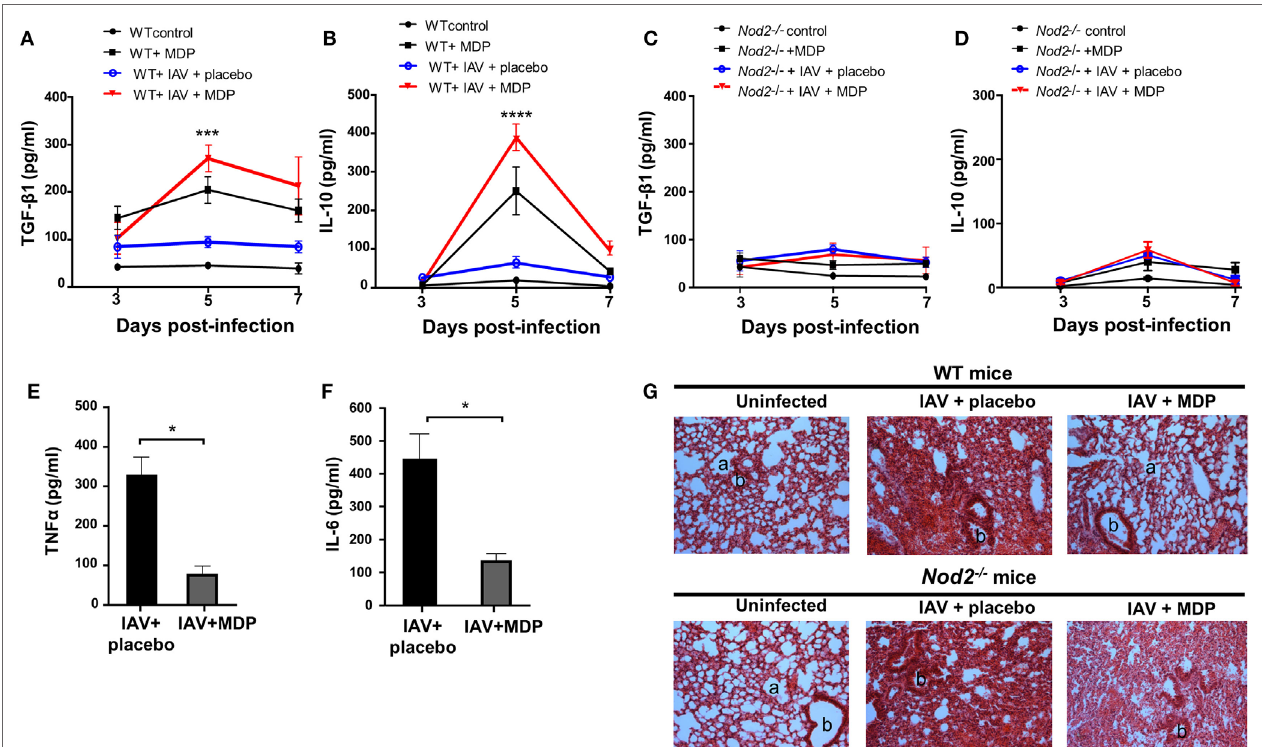
FigUre 4 | Muramyl dipeptide (MDP) treatment increases TGF- β and IL-10 secretion in lungs of influenza A virus (IAV)-infected mice. Levels of (a,c) TGF- β 1 and (B,D) IL-10 were measured in lungs homogenates of IAV-infected wild-type (WT) (left panel) and Nod2 − / − (right panels) mice daily treated with placebo or MDP. Lungs were collected at days 3, 5, and 7 postinfection. Results are presented as mean ± SEM of two independent experiments ( n = 4 mice/groups). Differences in groups were determined with a two-way analysis of variance followed by a Tukey post hoc test. *** p < 0.001 and **** p < 0.0001 as compared to IAV-infected mice treated with placebo. Levels of (e) TNF α and (F) IL-6 were assessed in lung homogenates of IAV-infected WT mice daily treated with placebo or MDP. Lungs were harvested at day 5 postinfection. Results are presented as mean ± SEM of two independent experiments ( n = 4 mice/groups). Differences in groups were determined with a Mann–Whitney test. * p < 0.05 when compared with indicated groups. (g) Hematoxylin and eosin-stained lung sections from uninfected or IAV-infected WT and Nod2 − / − mice, treated daily with placebo or MDP. Lungs were harvested at day 5 postinfection. Images are representative of two independent experiments ( n = 3 mice/group). a: example of alveolar and b: bronchiolar structure (original magnification 100 ×